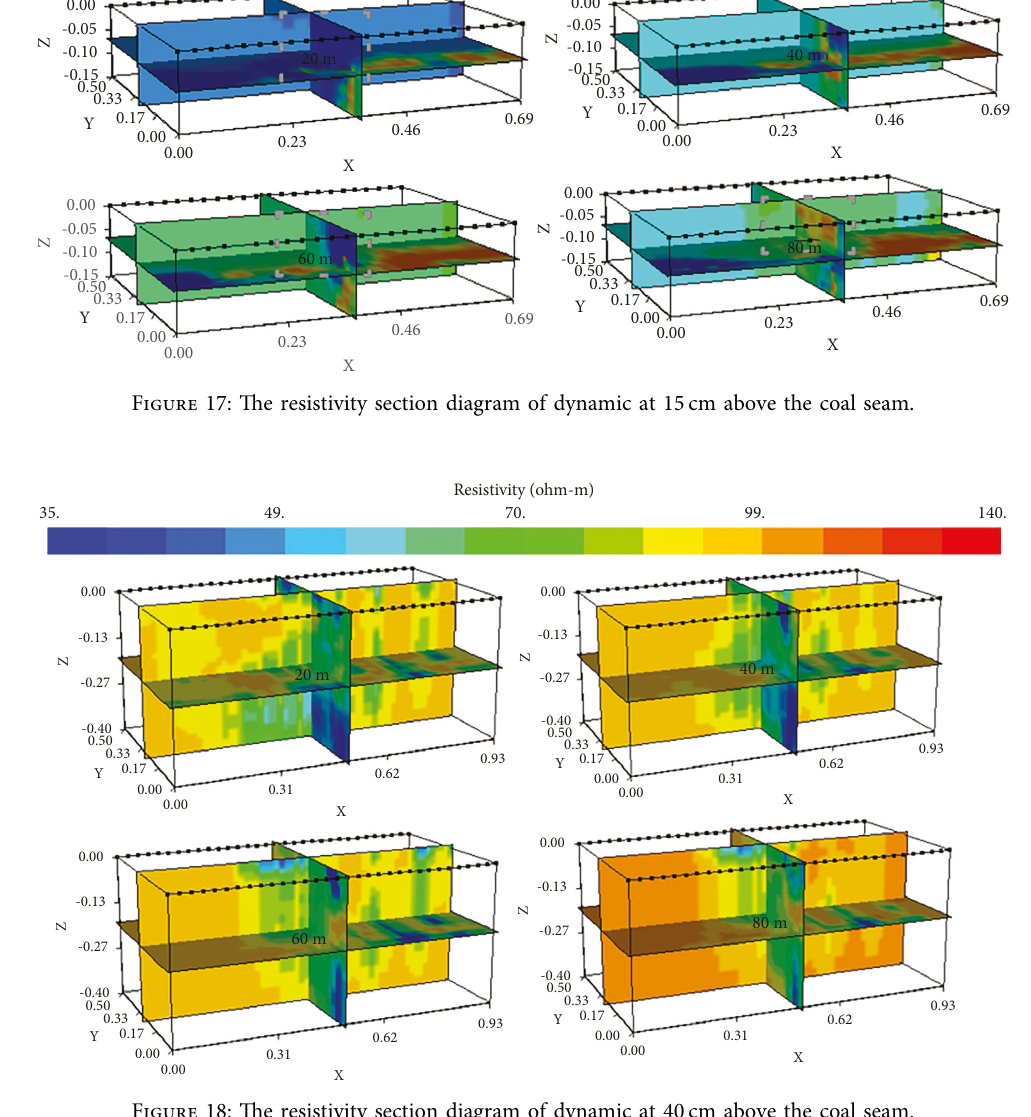
Figure 18: The resistivity section diagram of dynamic at 40cm above the coal